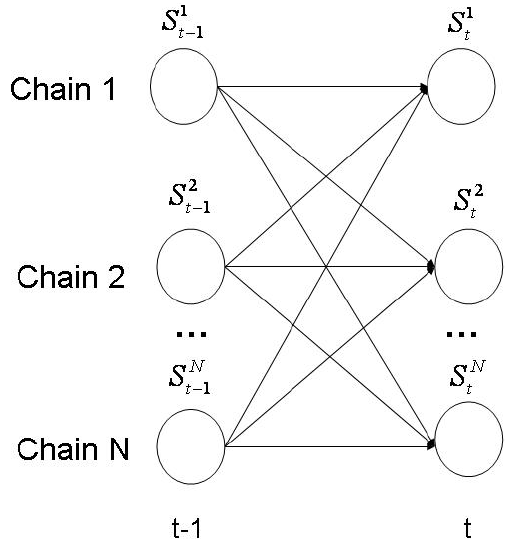
Figure 5. The Influence Model